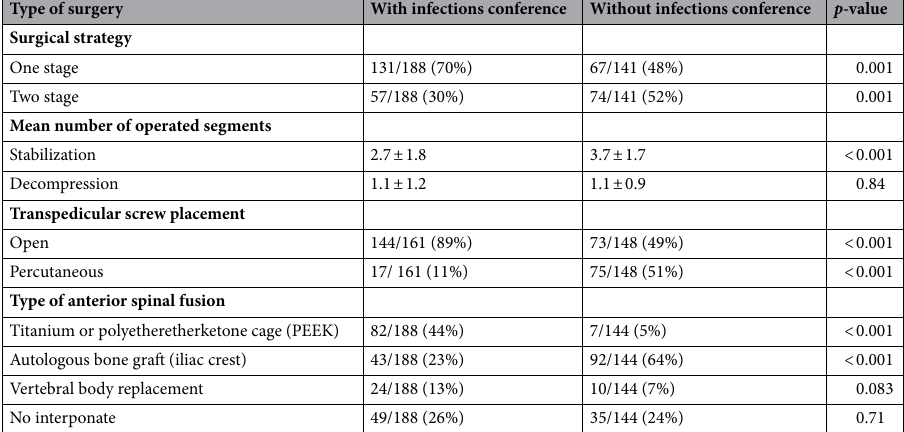
Table 3. Surgical strategy and techniques in both groups.